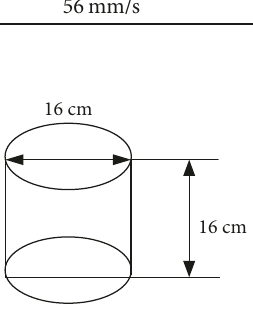
Figure 8: Product shape and size value.